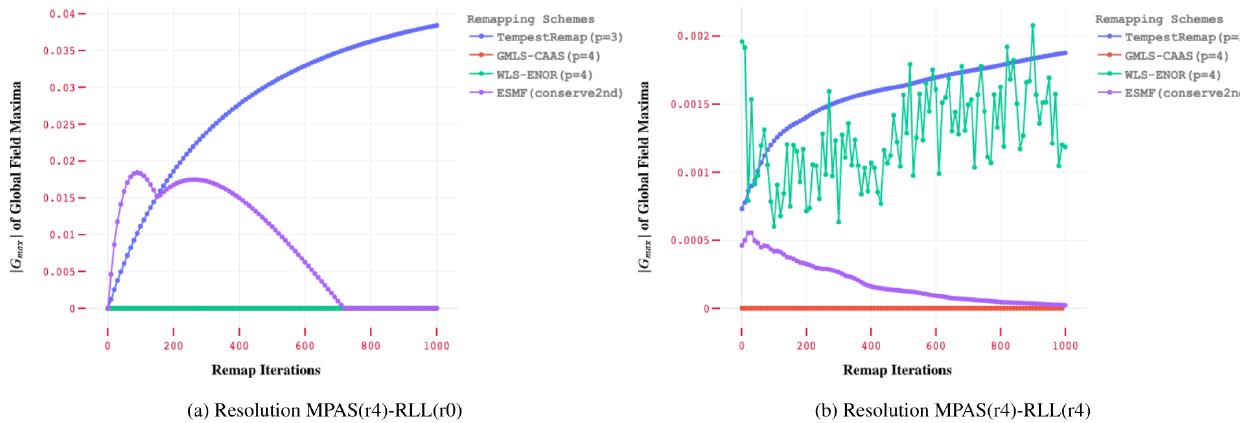
Figure 8. | G max | metric for the CFR field on MPAS-RLL with different target mesh resolutions.